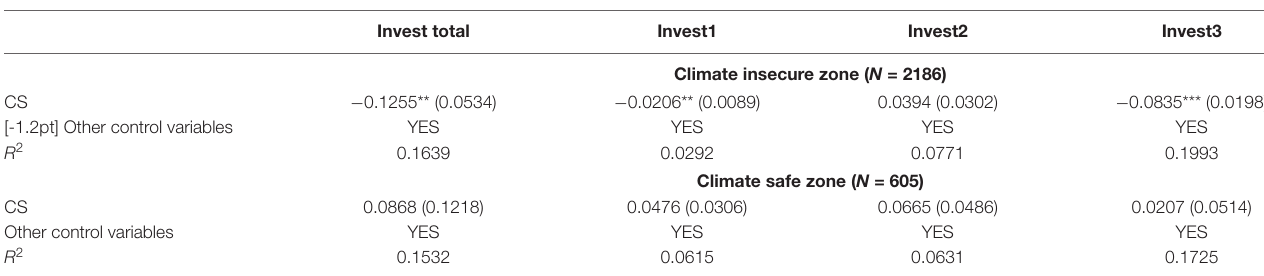
TABLE 8 | Climate shocks and farmers’ productive investment: Heterogeneity of village.